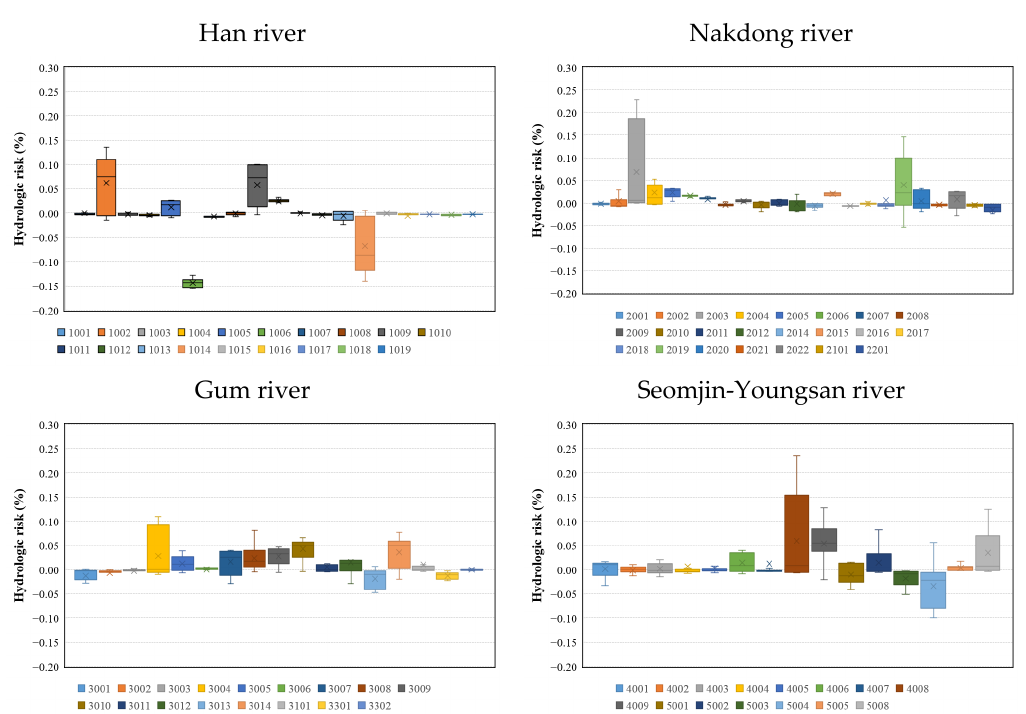
Figure 8. Hydrologic risks of individual basins according to the RCP 4.5.